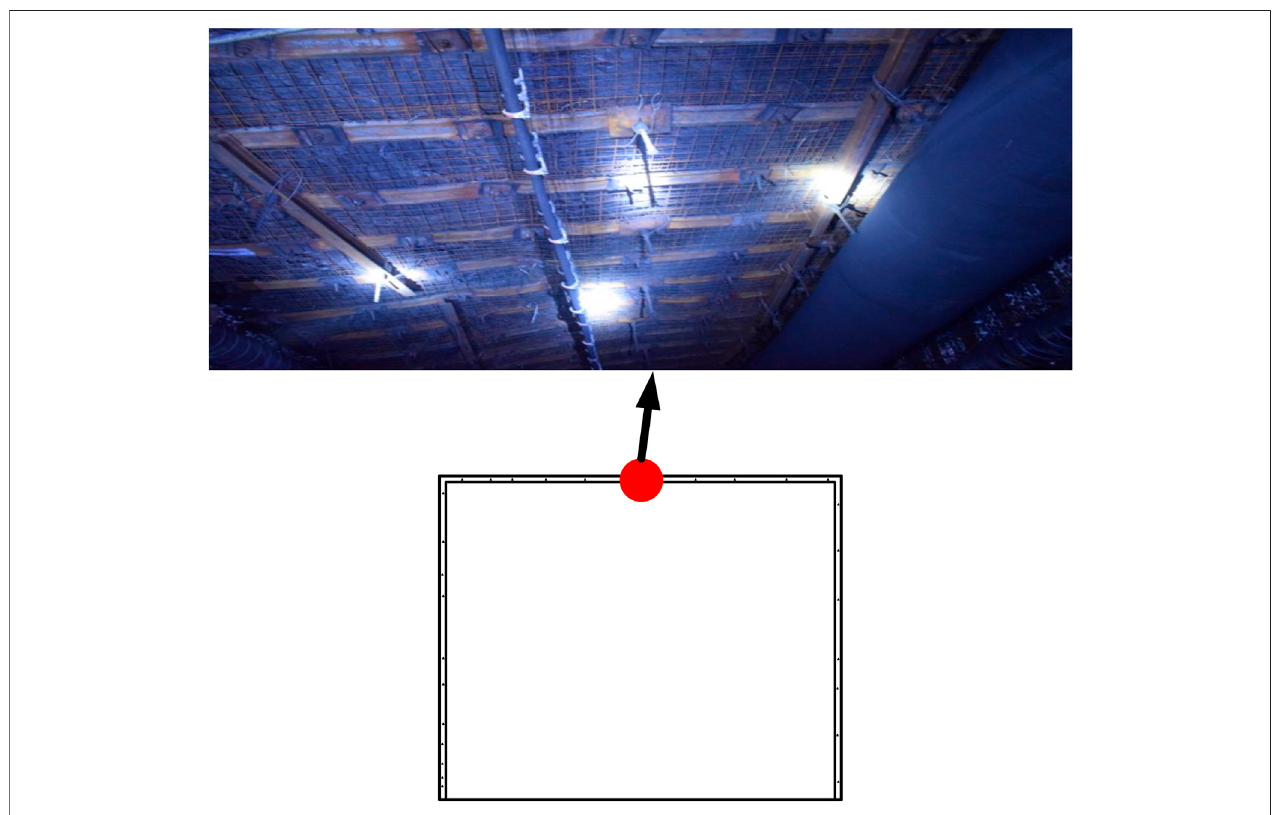
FIGURE 13 | Supporting effect diagram of improved scheme.